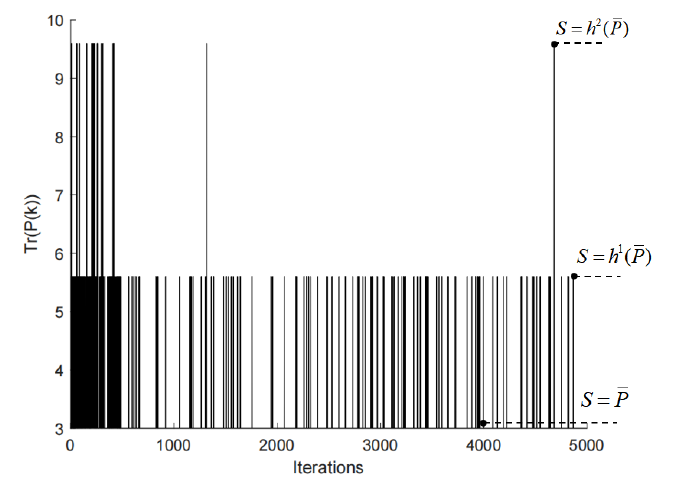
Figure 3. Variation of Tr ( P ( k )) for reliable channel.